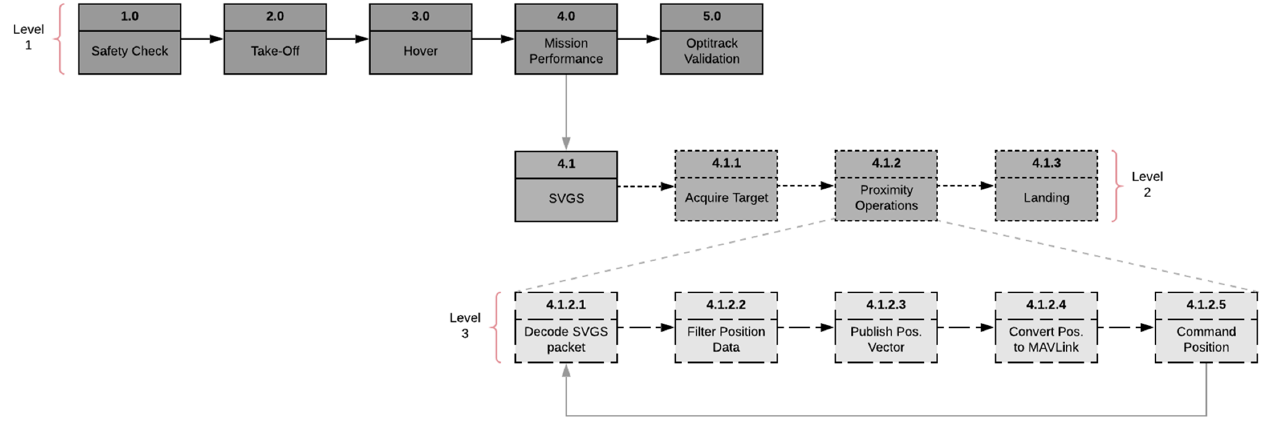
Figure 2. SVGS landing mission—functional flow diagram.